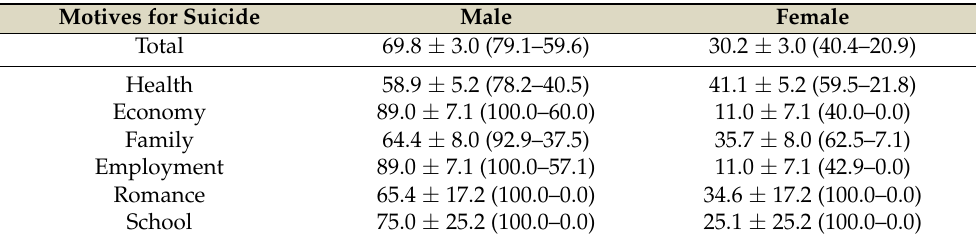
Table 1. Gender ratio of numbers of the six major suicide motives in the 47 prefectures of Japan from 2009 to 2018 (N = 470). Data are the mean ± standard deviation (maximum–minimum) (%). Motives for Suicide Male